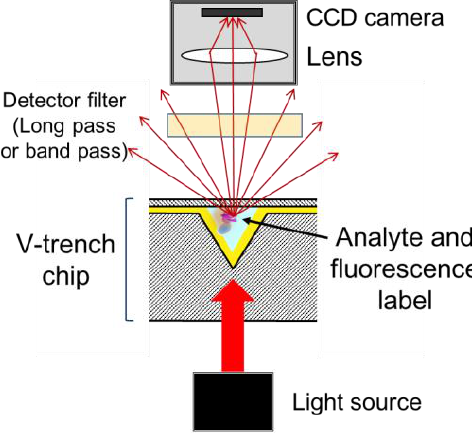
Figure 2. Schematic diagram of the V-trench biosensor.